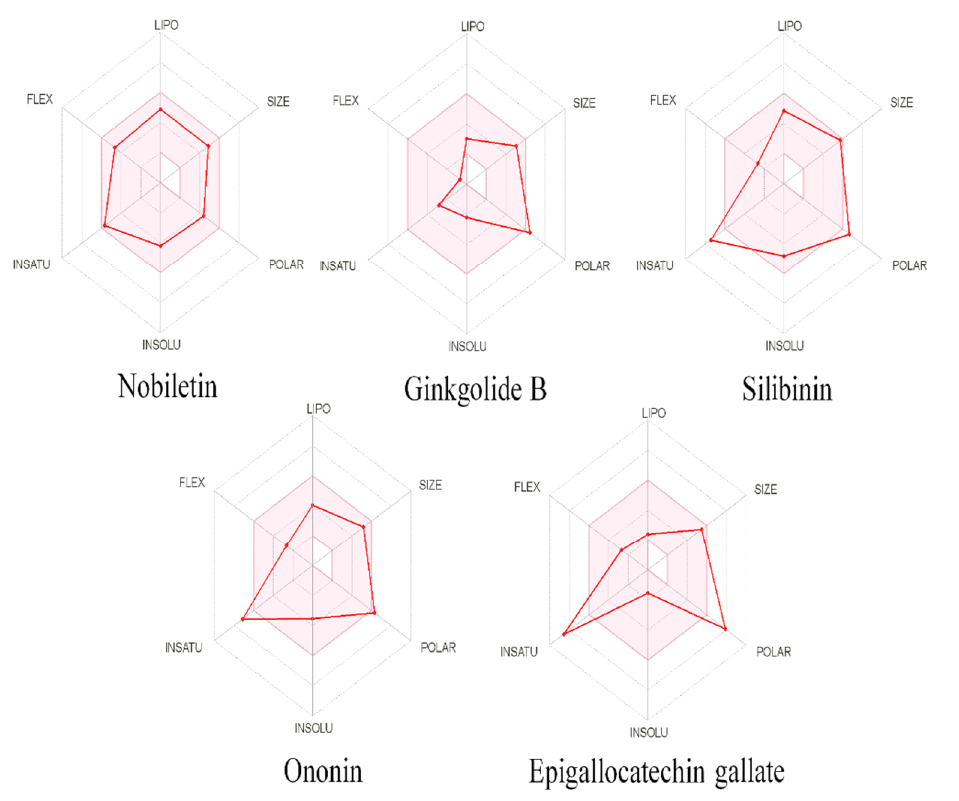
Figure 6. Physiochemical space for oral bioavailability, the colored zone is showing the allowed zone, and the red line showing the predicted natures of nobiletin, ginkgolide B, silibinin, ononin, epigallocatechin gallate.